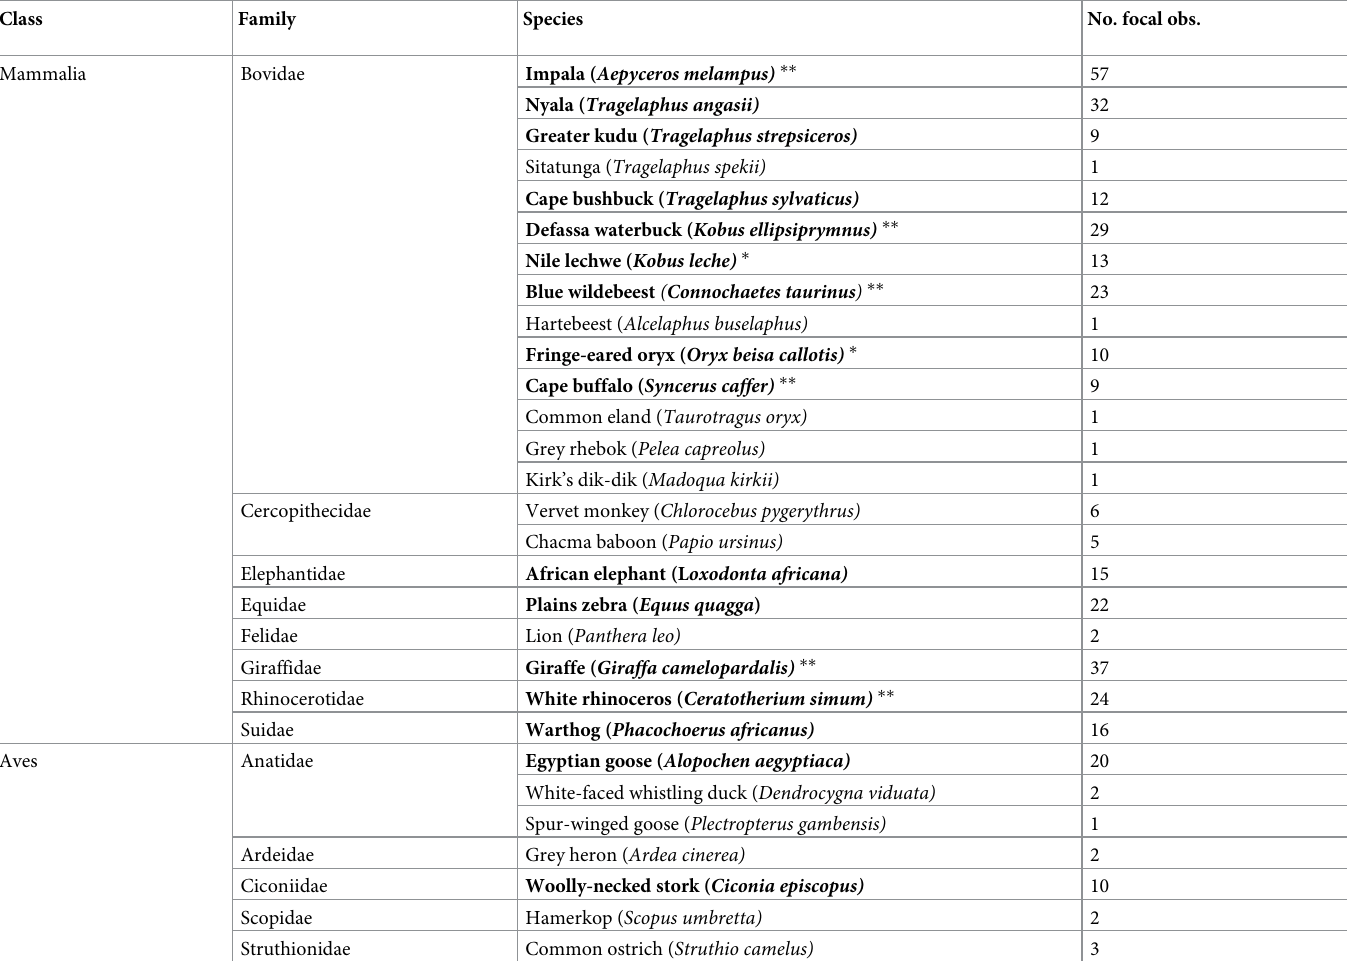
Those species coloured in grey were not included in the final analyses due to a low number of observations. * refers to a species observed in the zoo and ** refers to a species observed both in the zoo and in the